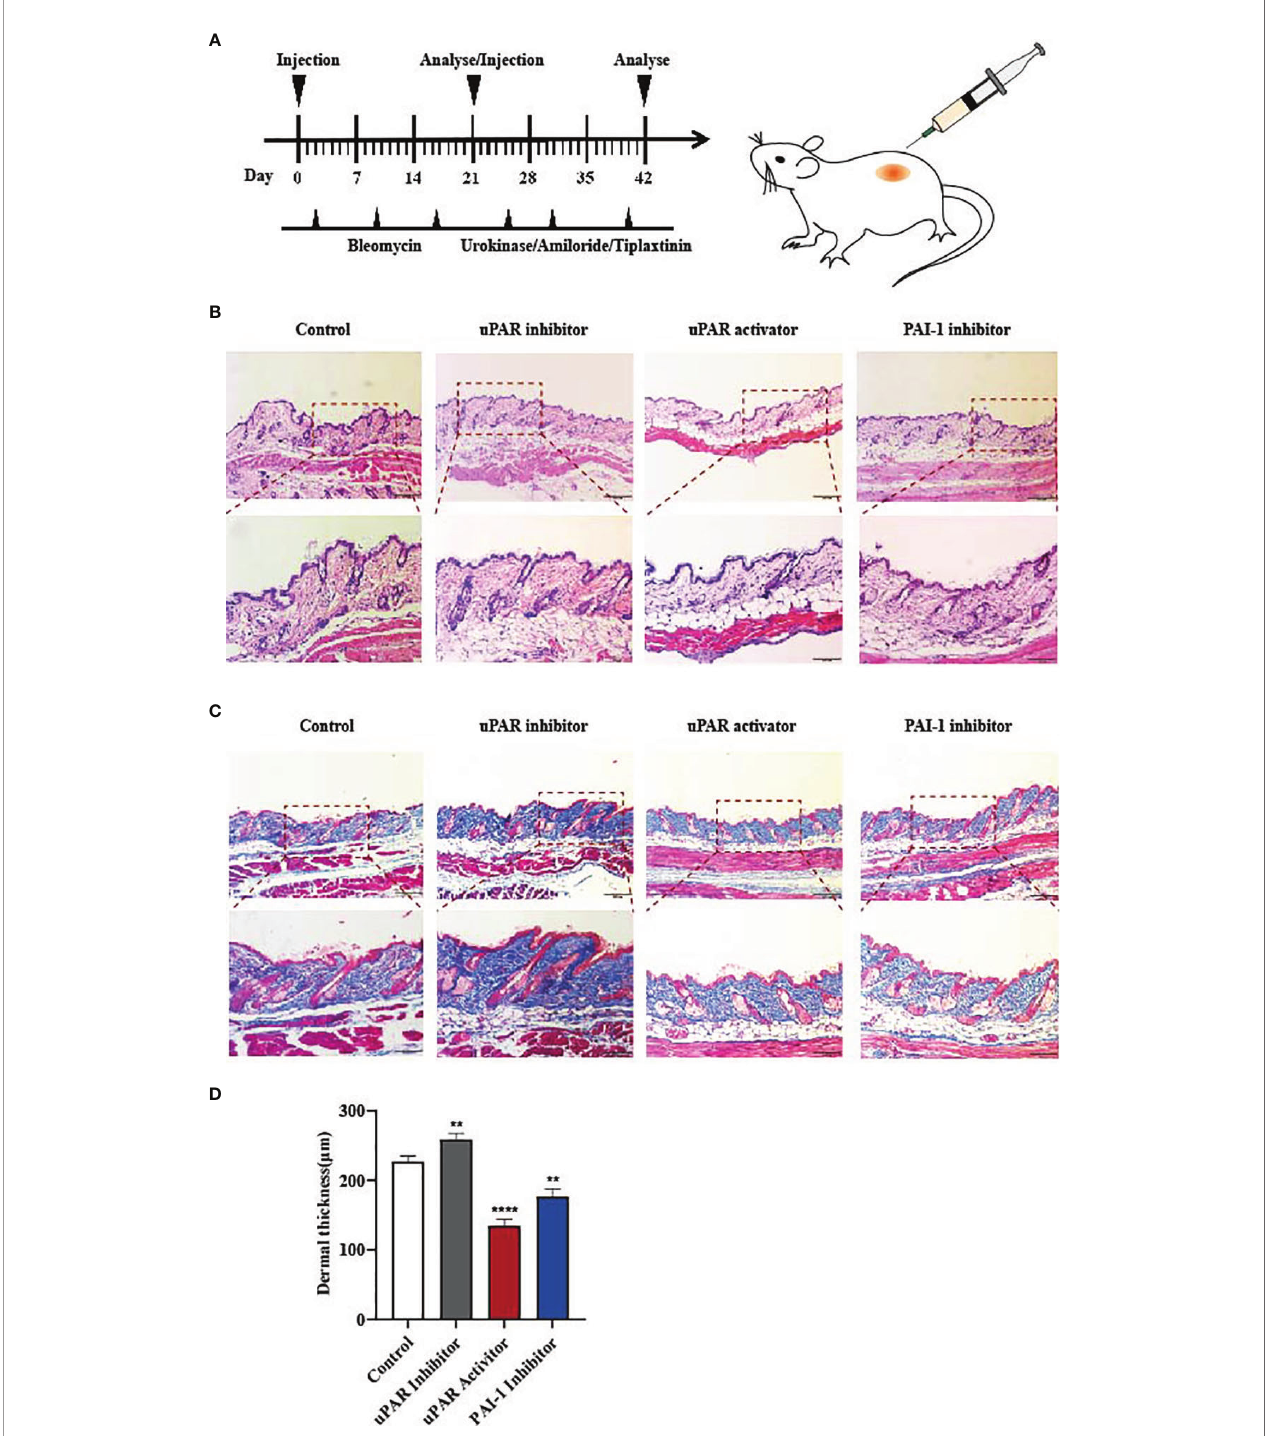
FIGURE 4 | Inhibition of PAI-1 and the addition of uPA attenuate skin fi brosis in vivo. (A) Schematic overview of experimental design for (B, C) . (B) uPAR agonist and PAI-1 inhibitor attenuate skin fi brosis, while uPAR inhibitor aggravate skin fi brosis. n = 5. Scale bar, 200 m m, 100 m m. (C) Masson staining of tissues at 21 days after drug administration. n = 5. Scale bar, 200 m m, 100 m m. (D) Quanti fi cation of dermal thickness ( m m). **P < 0.01 and ****P < 0.0001 when compared between the denoted